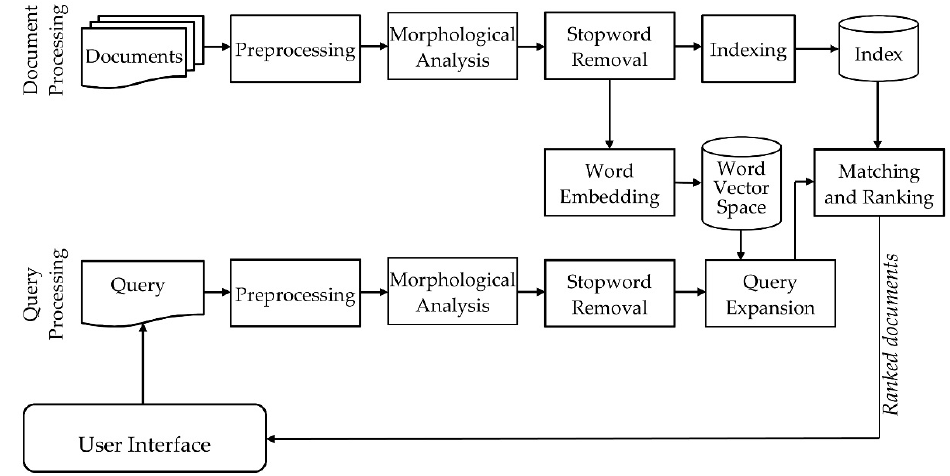
Figure 1. Architecture of the proposed Amharic IR system.